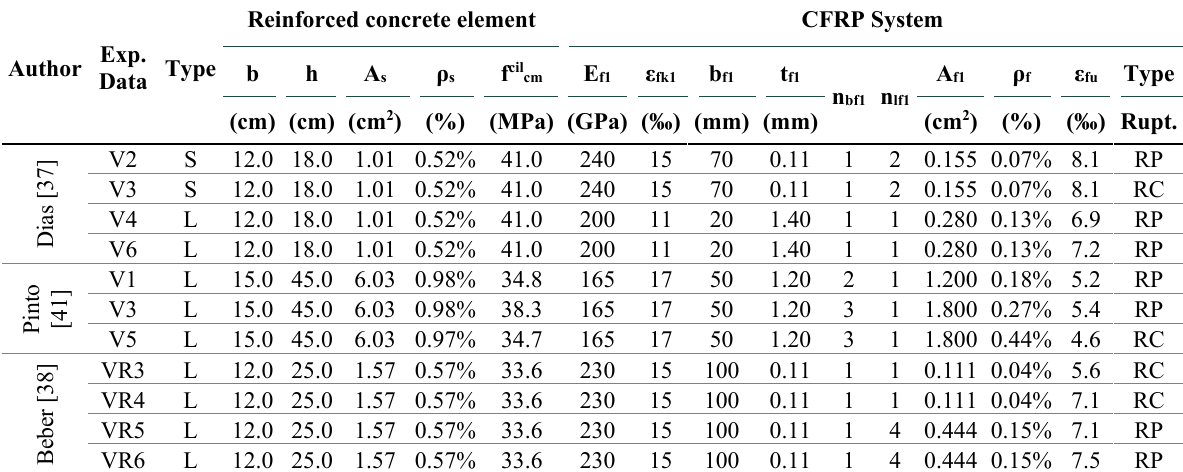
Table 2. Summary of the 52 experimental beams data used in this study.